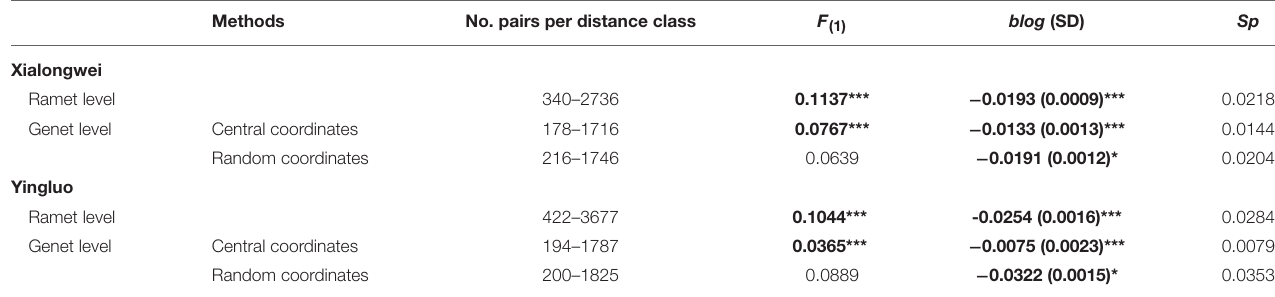
TABLE 4 | Summary of kinship autocorrelation within two